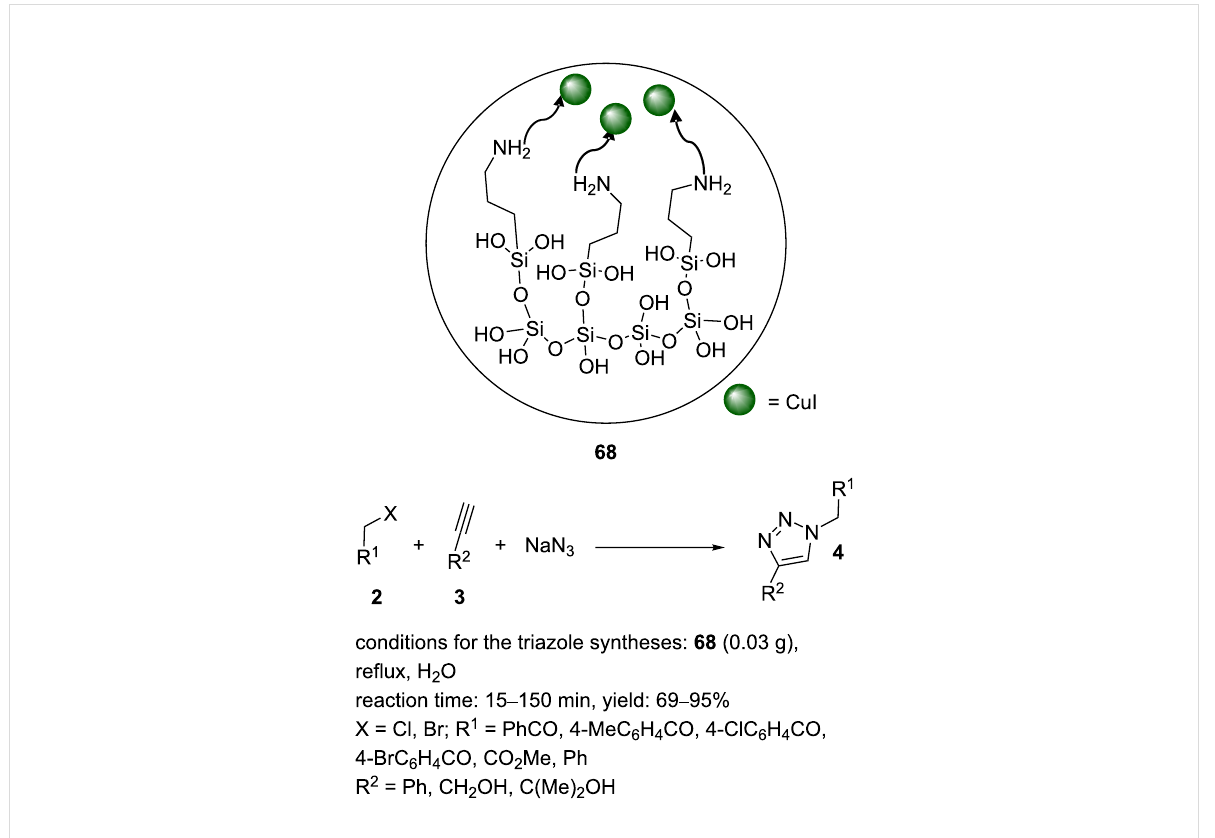
Scheme 11: Chemical structure of the catalyst 68 and catalytic application of 68 in “click”